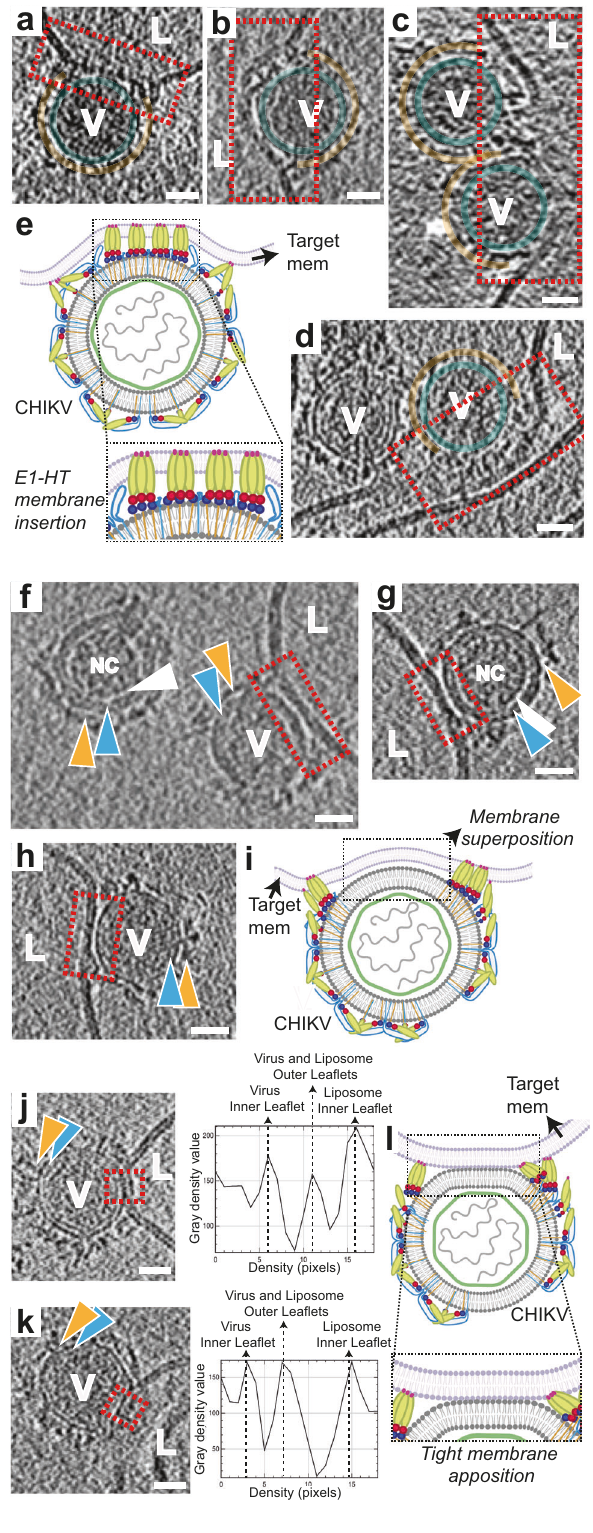
Fig. 4 | E1-HT membrane insertion and opposing membrane superposition (stages IV-VI). a – d Annotated tomogram slices showing insertion of protein den- sities into the liposome (L) causing disruption of membrane density at the inter- face.CHIKV(V)areannotatedsimilartoprevious fi gureswithreddottedrectangles enclosinginteractionareasofinterest. e CartoonrepresentationoffusionstageIV – E1-HT membrane insertion. Created with Biorender.com. f – h Tomogram slices showingsuperpositionoftheviralandliposomemembranes.Interactioninterfaces are enclosed in red rectangles. Variation and fl uidity in the glycoprotein layer (orange triangles) can be seen in f , g . White triangles represent the gap observed betweentheNCandinnersurfaceoftheviralmembrane(bluetriangles). i Cartoon representation of fusion stage V — membrane superposition, with dotted rectangle outlining the interface. Created with Biorender.com. j , k Tomogram slices howing tightlydockedmembraneinterfaceswiththeproximallea fl etstooclosetoseparate at the current tomogram resolution. Corresponding electron density plots along a L line traversing the tight-membrane interface in the boxed region (red) of the tomogram slices are also shown. l . Cartoon representation of the tightly docked membrane interface (stage VI) with zoomed inset showing region of interest. Created with Biorender.com. Scale bar is 200Å and black is high density in all